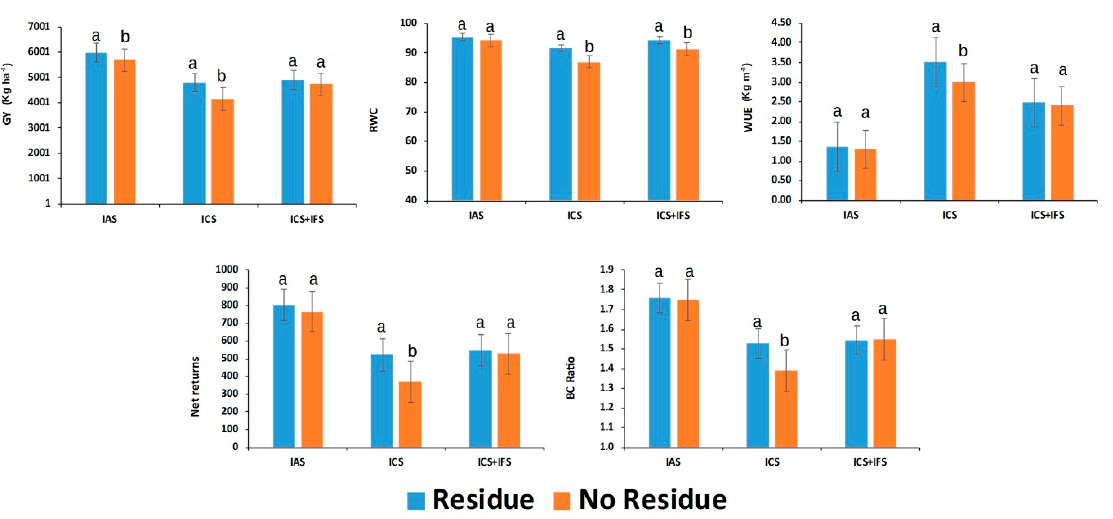
Figure 5. Interaction effect of rice residue retention and irrigation levels on GY and profitability parameters of wheat. Means having different letter are significantly different from each other at 5% significance level.